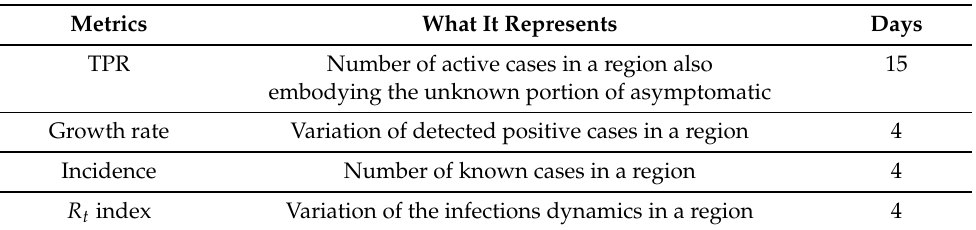
Table 4. Pure predictive capacity in days of different COVID-19 indicators with respect to hospital-